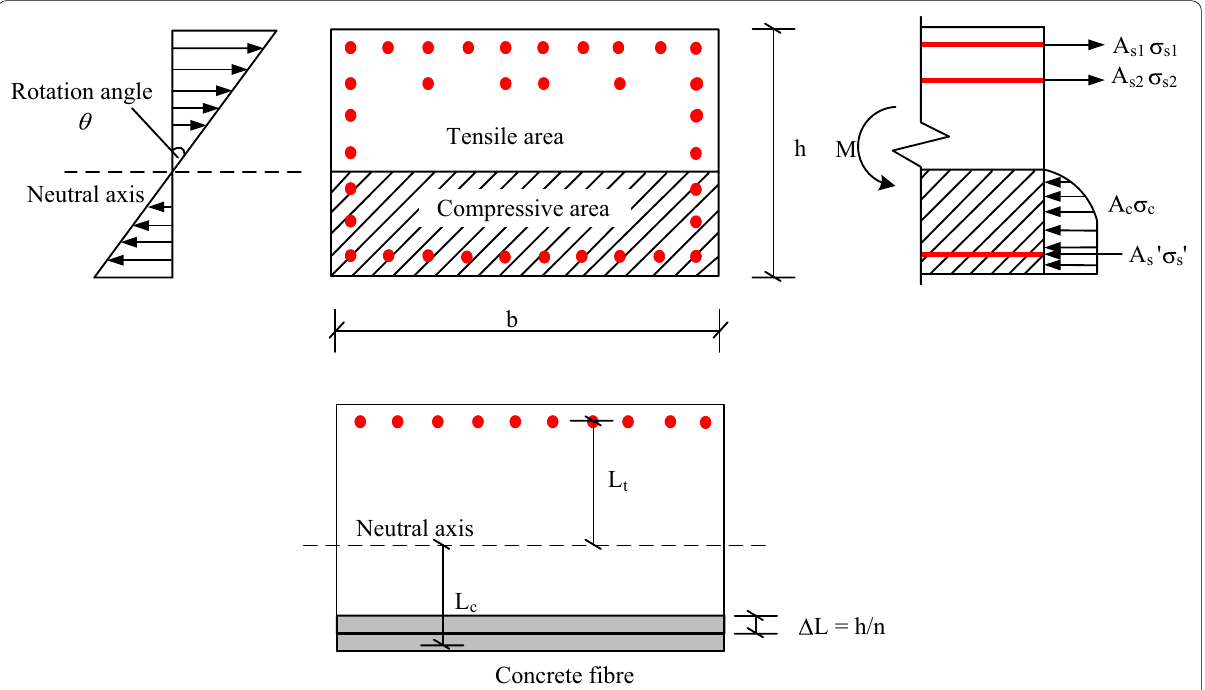
Fig. 24 Calculation diagram of the flexural capacity of the strut’s positive